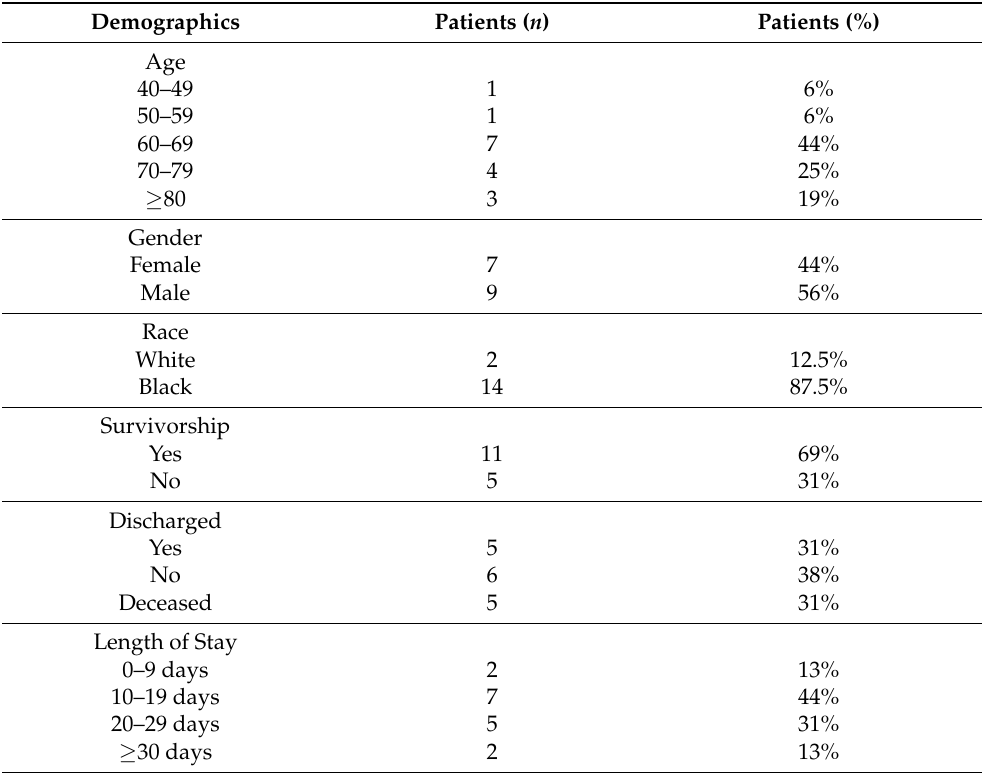
Table 1. Demographics of the cohort of patients assigned to the medical students in a tele-ICU rotation, Perelman school of Medicine, April